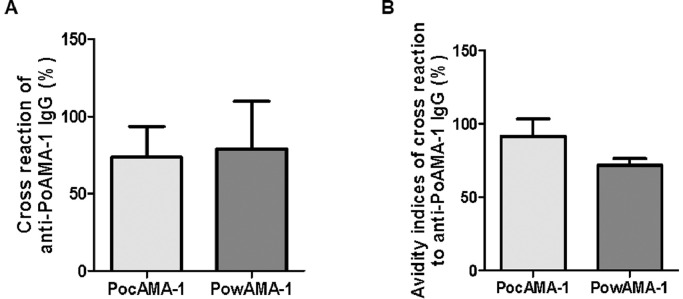
Cross reactivity. (A) Cross reactivity of anti-rPoAMA-1 IgG. (B) Avidity indices of cross reaction to anti-rPoAMA-1 IgG. Significant differences between groups are denoted on the graph: * P < 0.05, **P < 0.01, *** P <0.001. Nonsignificant (ns) differences are indicated (P > 0.05).